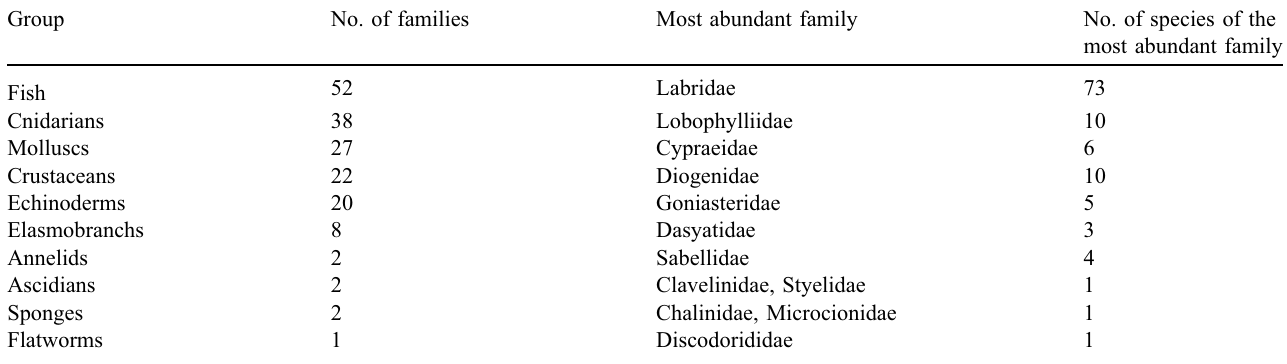
Table 2. Groups of marine animals found being traded in Indonesia in 2018, and number of families, the most abundant family and number of traded species in the most abundant family in each